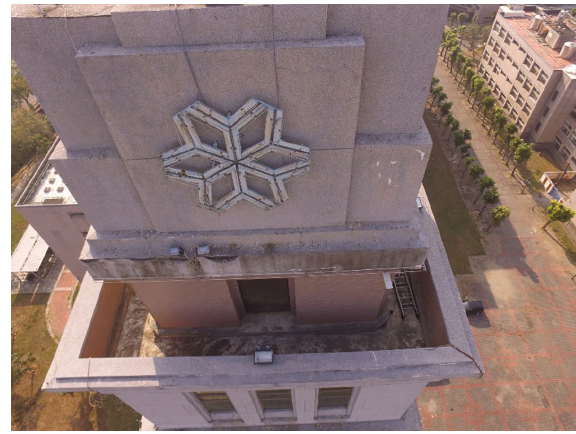
Figure 5. Overhead photography by UAV’s camera